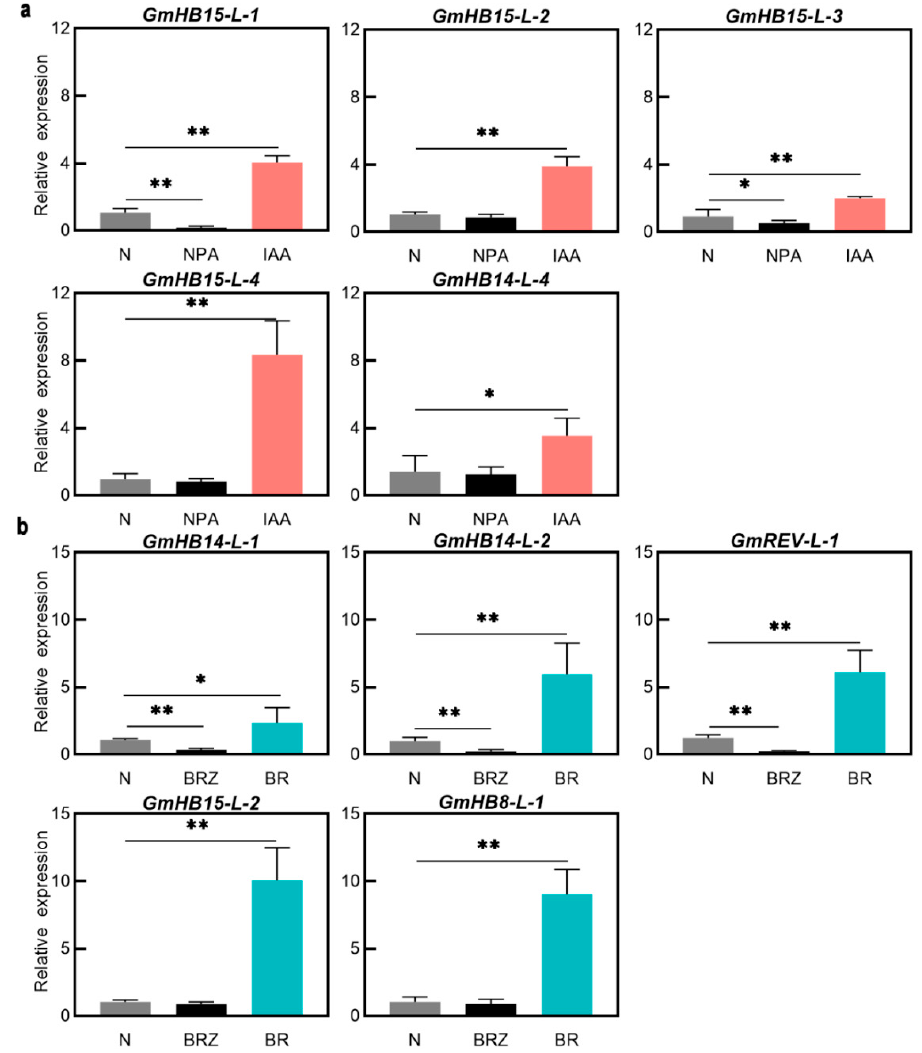
Figure 4. ( a ) Expression profiles of GmHD-Zip III genes under IAA and NPA. ( b ) Expression profiles of GmHD-Zip III genes under BR and BRZ . Asterisks indicate significant differences between controls and treatments (* p < 0.05, ** p < 0.01).